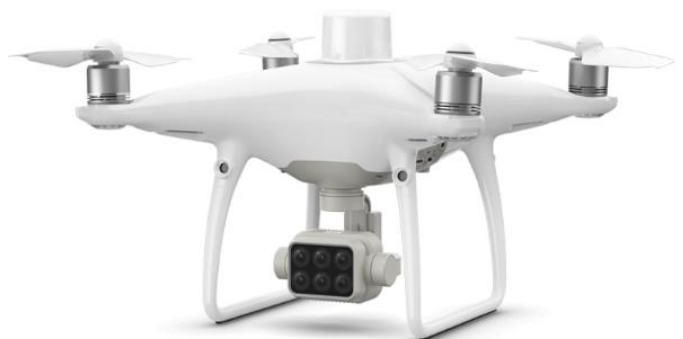
Figure 2. A photo for Phantom 4 multispectral. Table 2. Spectral parameters of multispectral sensors.